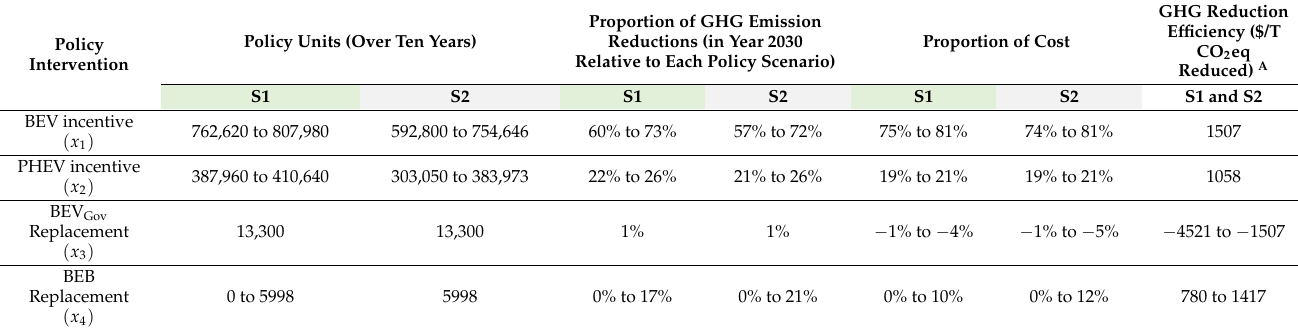
Table 3. The range of policy unit allocation, proportion of GHG emission reductions, proportion of cost, and GHG reduction efficiency of provincial policies for policy scenario 1 (S1) and 2 (S2). The range of values is a result considering the upper and lower bounds of TCO and EV